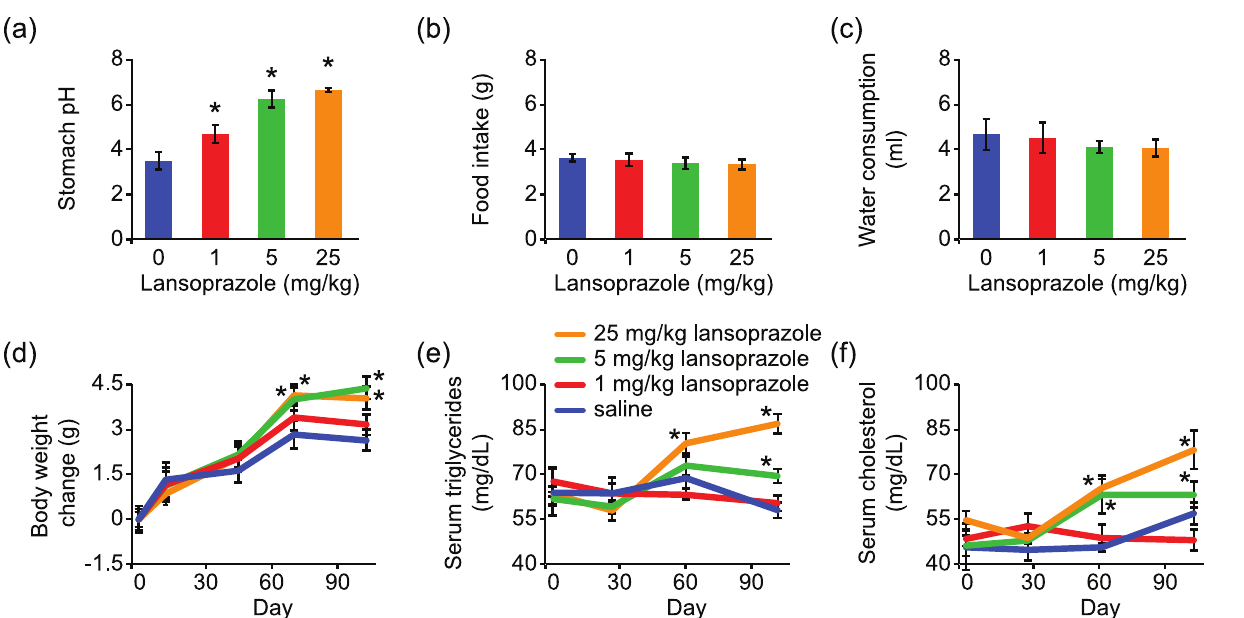
Fig 5. Gastric acid suppression induces an obese-like phenotype in mice. (a) Increased stomach pH in mice receiving lansoprazole treatment. (b and c) Chronic lansoprazole treatments do not affect food intake (b) or water consumption (c) of mice. (d-f) Chronic lansoprazole treatments gradually induce increased body weight, and elevated levels of serum triglycerides and cholesterol. Data were collected from 7 mice for each group. * , P < 0.05, compared to the saline group.